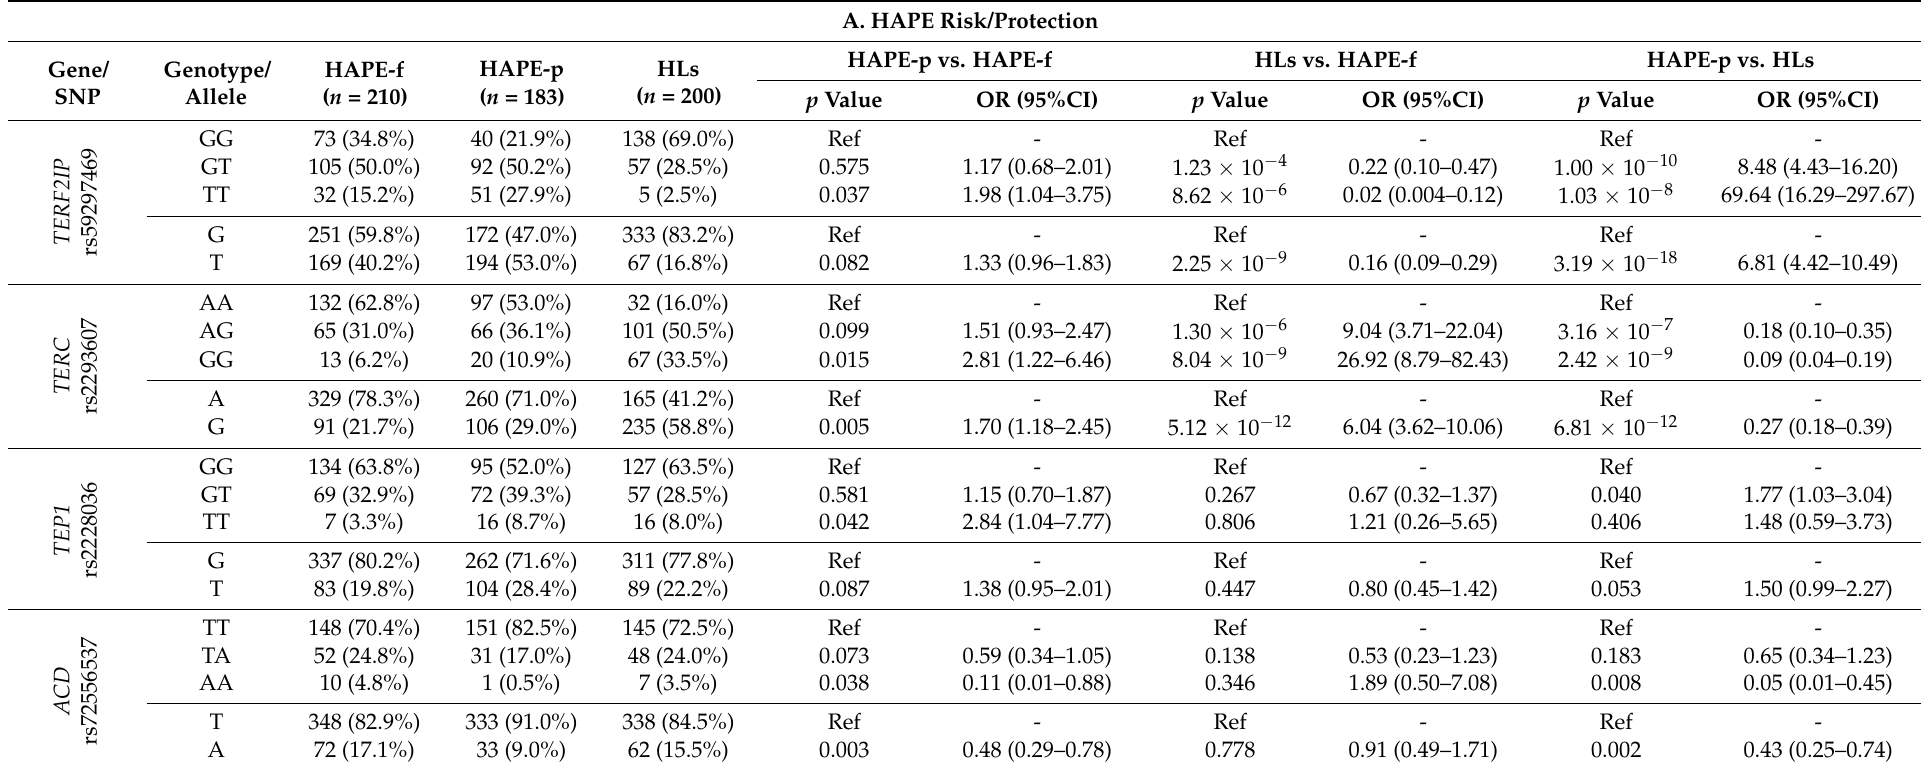
Table 1. Genotype and allele distribution in HAPE-f, HAPE-p and